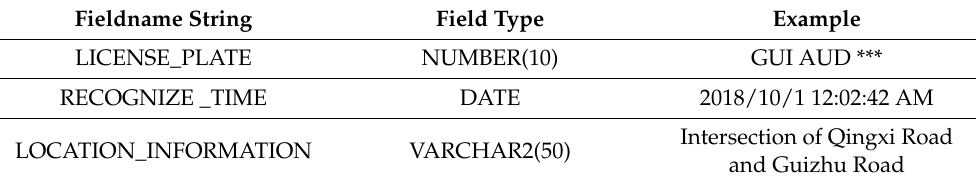
Table 1. Road vehicle license plate data